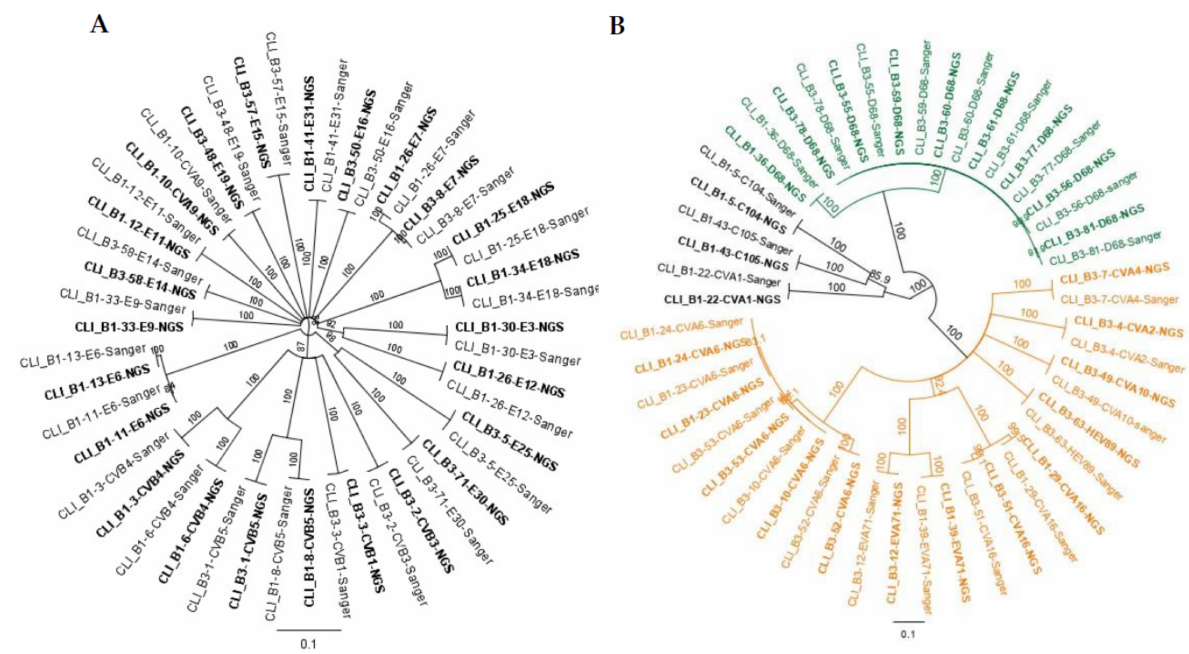
Figure 3. Similarity between nucleotide sequences from EVs present in clinical samples using NGS analysis (bold text) or nested VP3-VP1 Sanger sequencing (plain text). ( A ) species B EVs. ( B ) species A (orange), C (black), and D (green) EVs. Phylogenetic tress were generated using the Maximum Likelihood method and Tamura-Nei model using MEGA X software. The percentage of replicate trees in which the associated taxa clustered together in the bootstrap test (1000 replicates) are shown next to the branches.